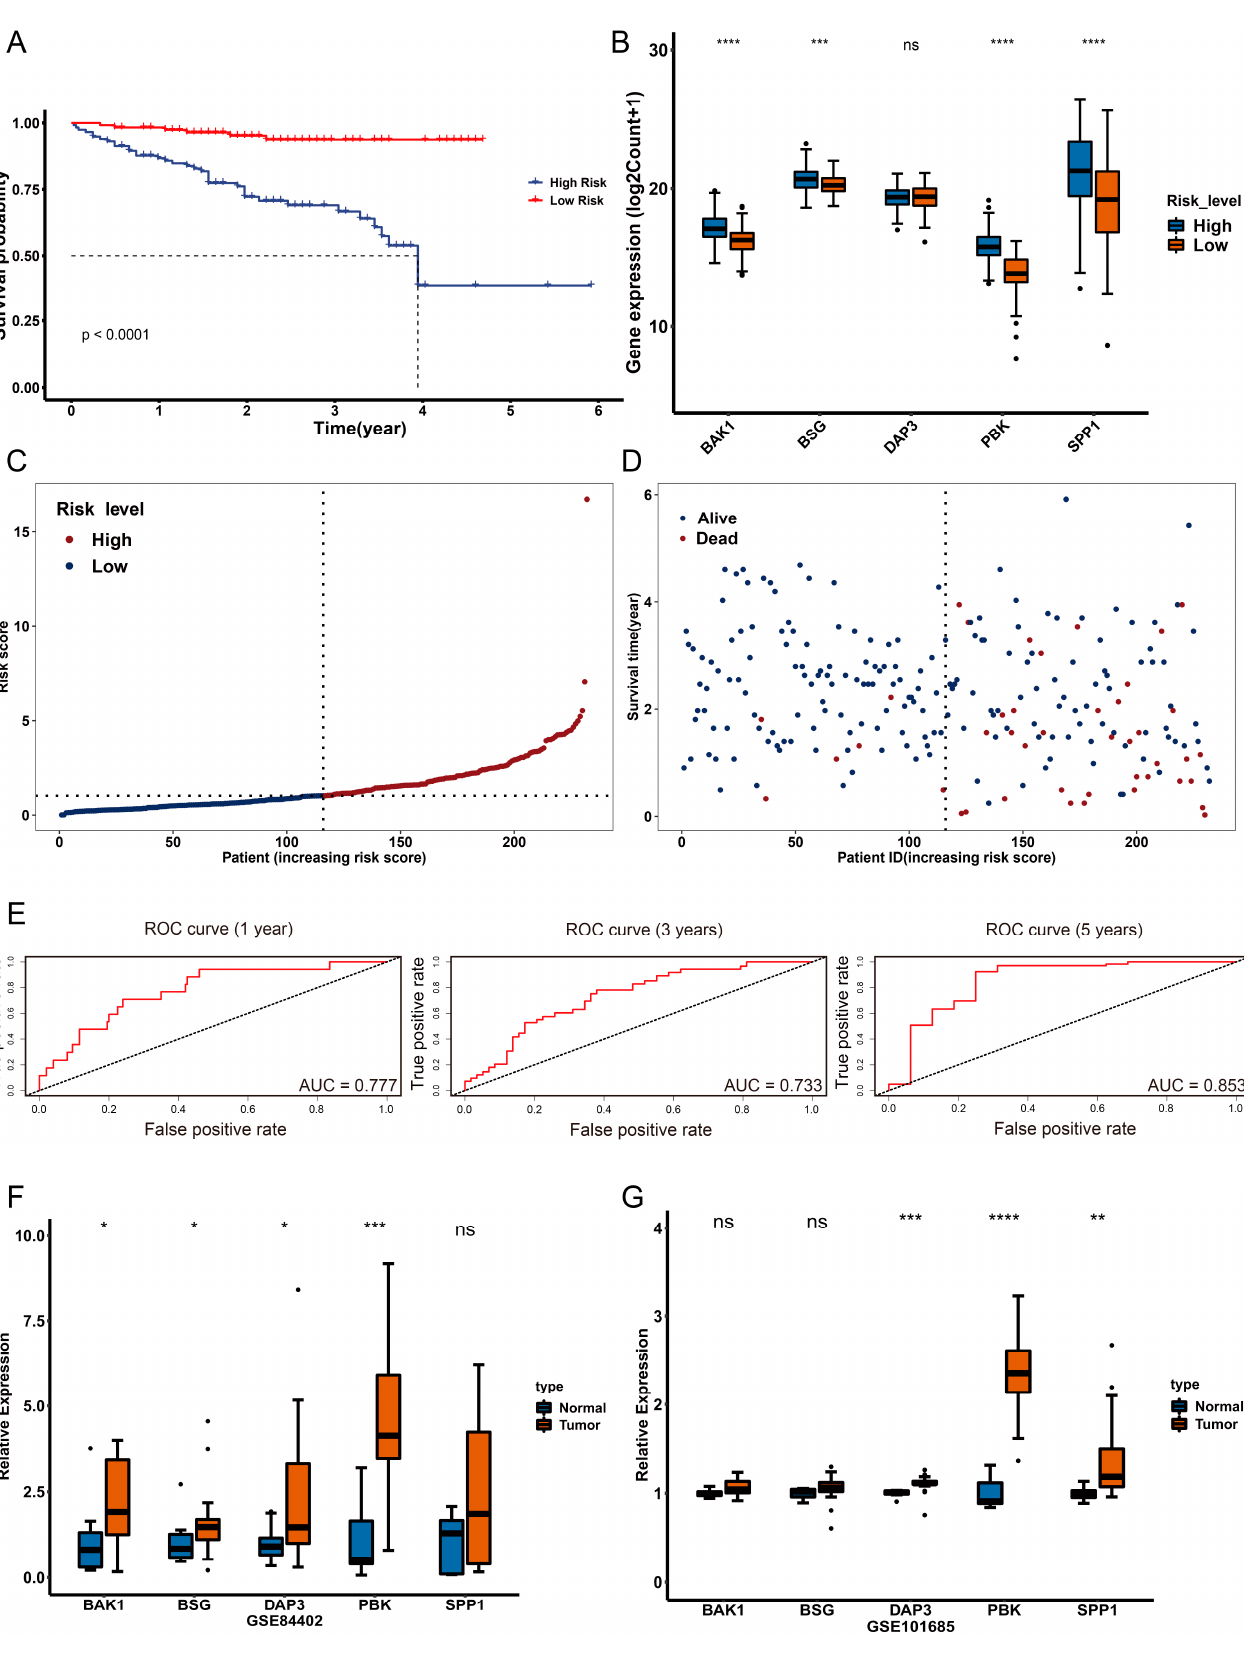
Figure 7. Validation of the anoikis-related prognostic risk model. ( A ) The overall survival of the different risk groups in the ICGC dataset. Blue represents patients in the high-risk group and red represents patients in the low-risk group. ( B ) Boxplot of expression of the prognostic genes in the